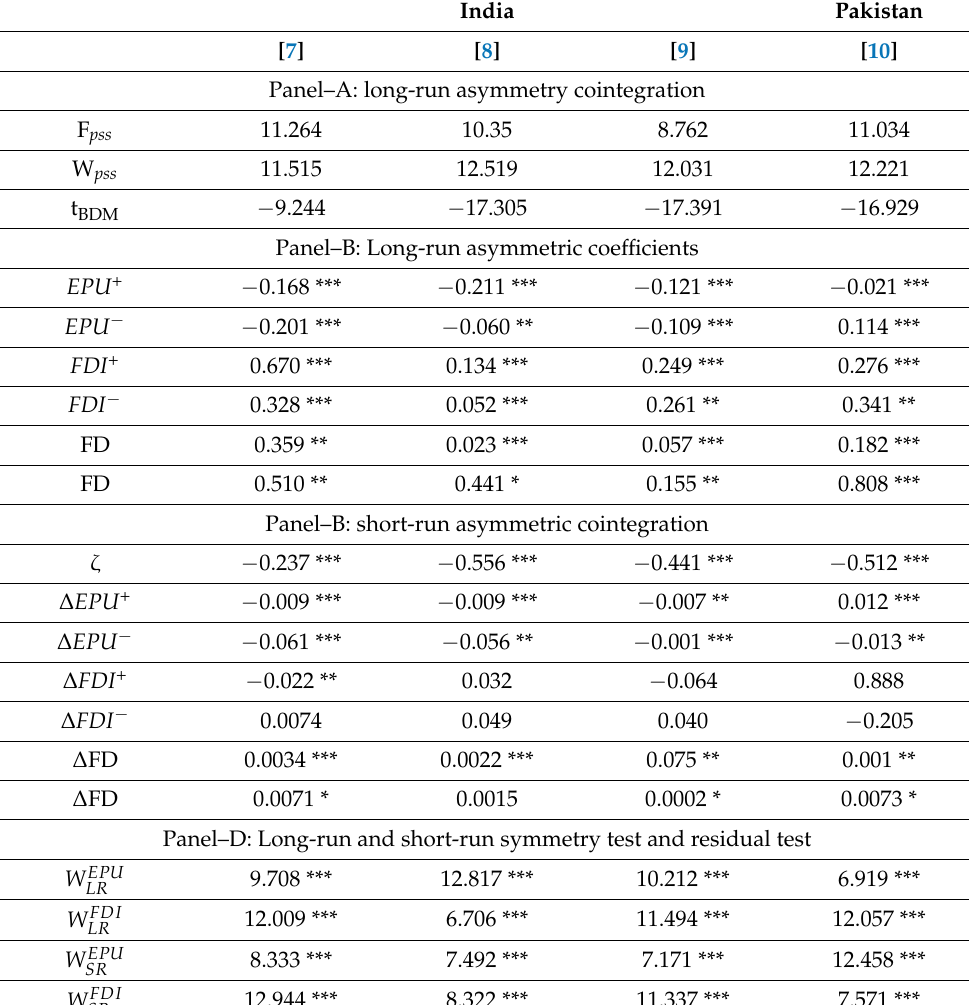
Table 9. Results of asymmetric effects of EPU , FDI , and FD on